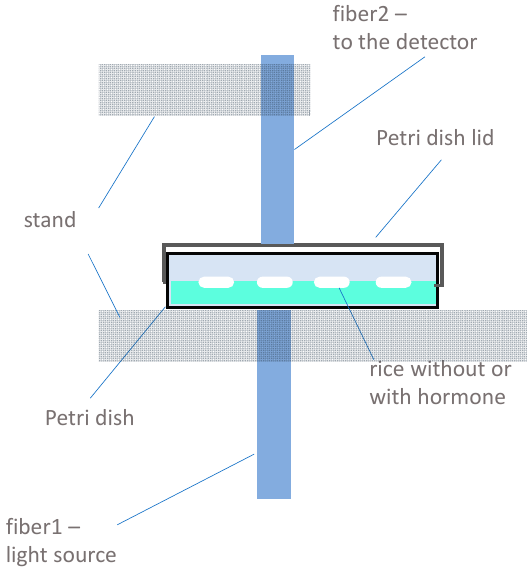
Figure 7. Scheme of the experimental measurement setup.